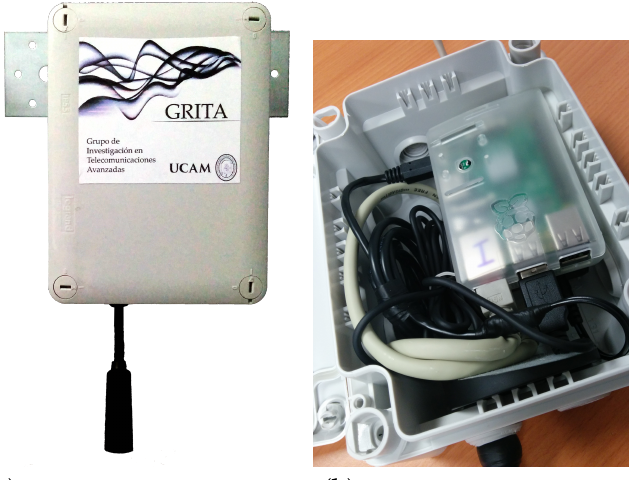
Figure 5. Views of the physical prototype built. ( a ) Final design of the acoustic device. In the picture, the Raspberry Pi and the other components are inside a protected box. At the bottom part of the box, the microphone can be observed; ( b ) Interior view of the waterproof case. The components inside of it are the Raspberry Pi together with the POE splitter, the microphone at the bottom of the picture and all the cables for the